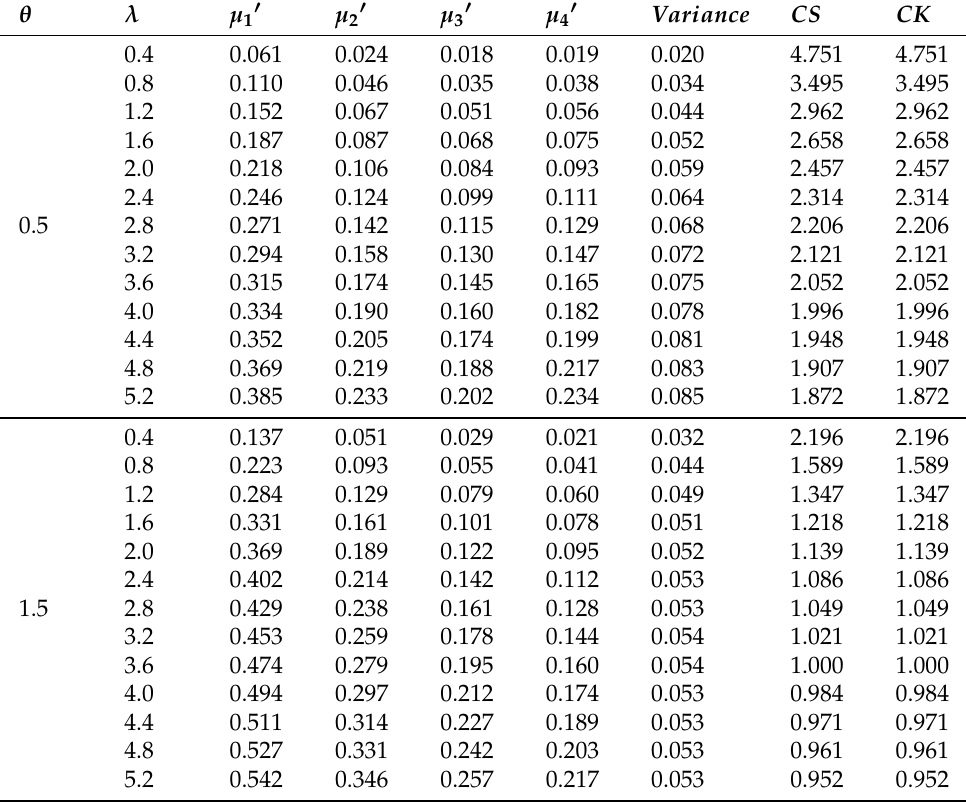
Table 3. Moments for TLMW distribution at α = β =